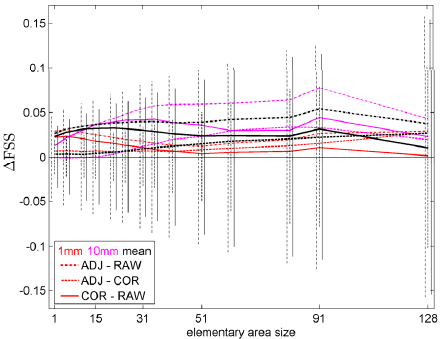
Fig.2. The mean FSS difference ( Δ FSS) against the spatial scale for 3 h rainfall. The scale Fig. 2. The mean FSS difference ( 1 FSS) against the spatial scale (horizontal axis) is marked by the number of grid points at the side of the square elementary for 3h rainfall. The scale (horizontal axis) is marked by the num- area. Like in the Fig. 1, the label 128 marks the entire domain. The mean Δ FSS values were ber of grid points at the side of the square elementary area. Like in calculated over all events and integration times. They refer to various radar-based data types the Fig. 1, the label 128 marks the entire domain. The mean 1 FSS as indicated in the legend. The color curves correspond to the thresholds 1 mm and 10 mm. The black curves show means over all the threshold values considered (1, 2, 5, and 10 mm) values were calculated over all events and integration times. They and the black vertical lines indicate corresponding standard deviation values. refer to various radar-based data types as indicated in the legend. The color curves correspond to the thresholds 1mm and 10mm. The black curves show means over all the threshold values con- sidered (1, 2, 5, and 10mm) and the black vertical lines indicate corresponding standard deviation values.